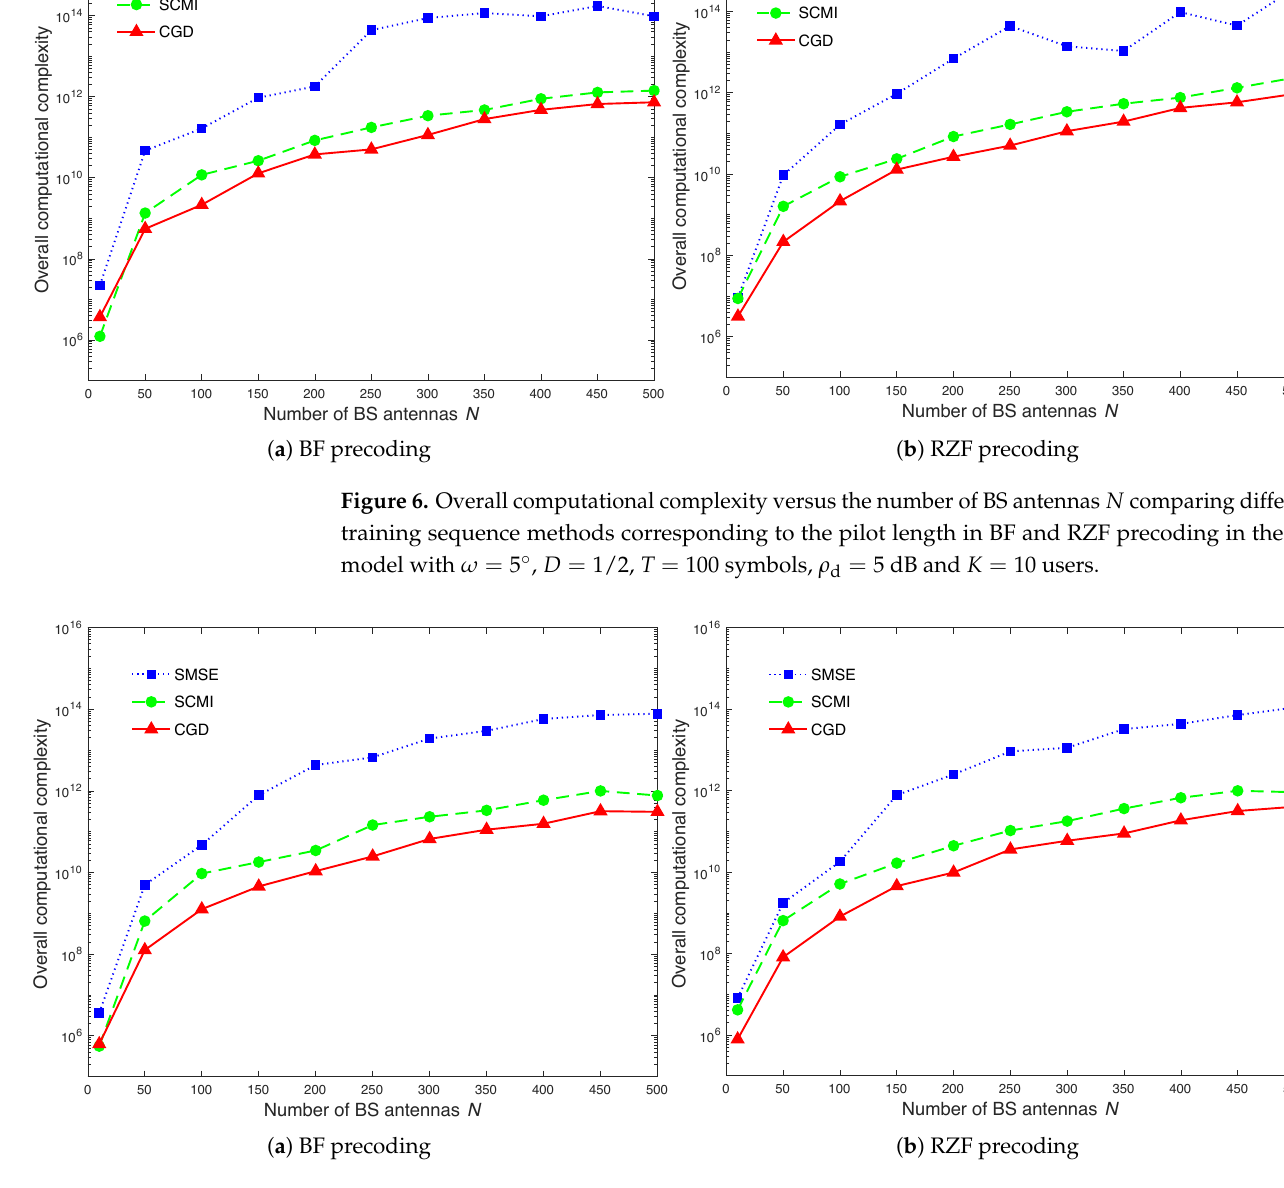
Figure 7. Overall computational complexity versus the number of BS antennas N comparing different training sequence methods corresponding to the pilot length in BF and RZF precoding in the OR model with ω = 5 ◦ , D = 1/2, T = 100 symbols, ρ d = 10 dB and K = 6